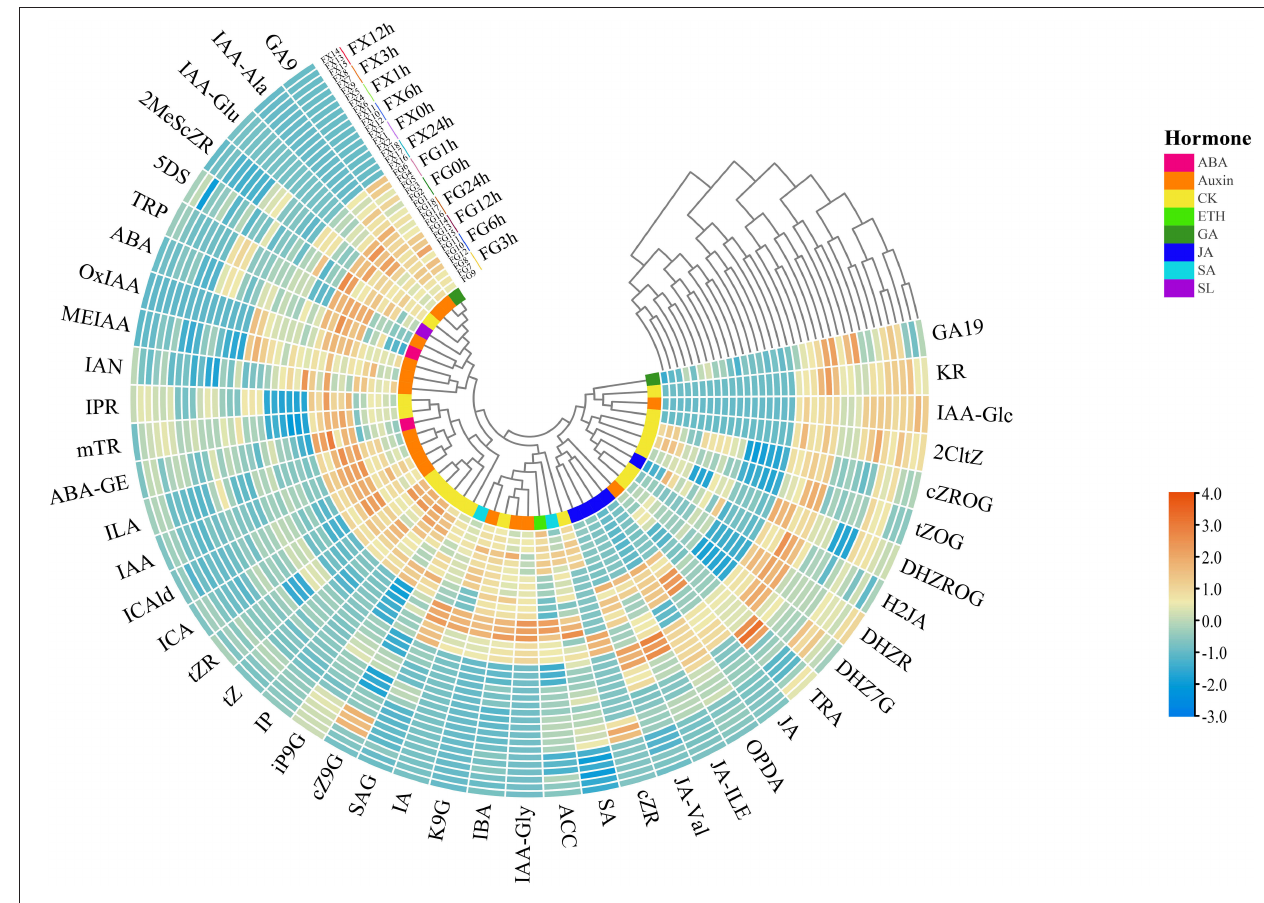
Frontiers in Plant Science |